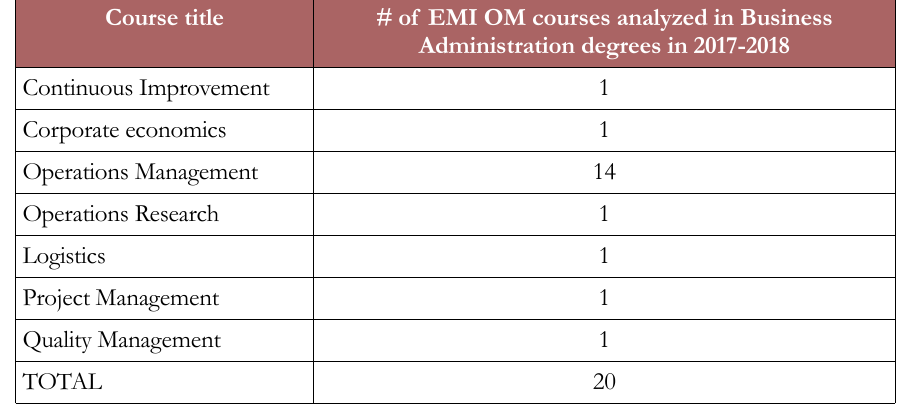
Table 2. OM courses given by participating